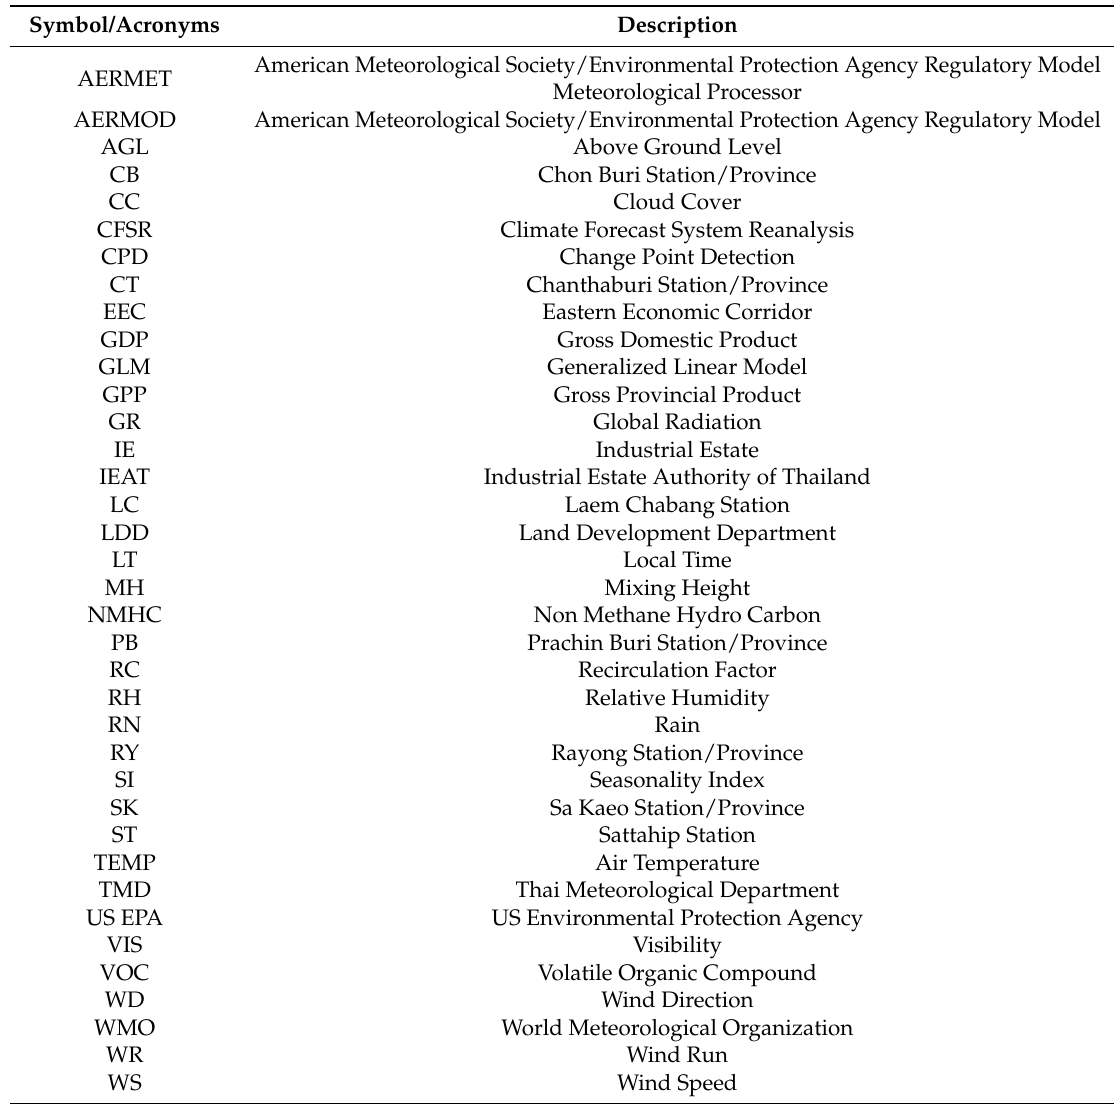
Table A1. Nomenclature used in the